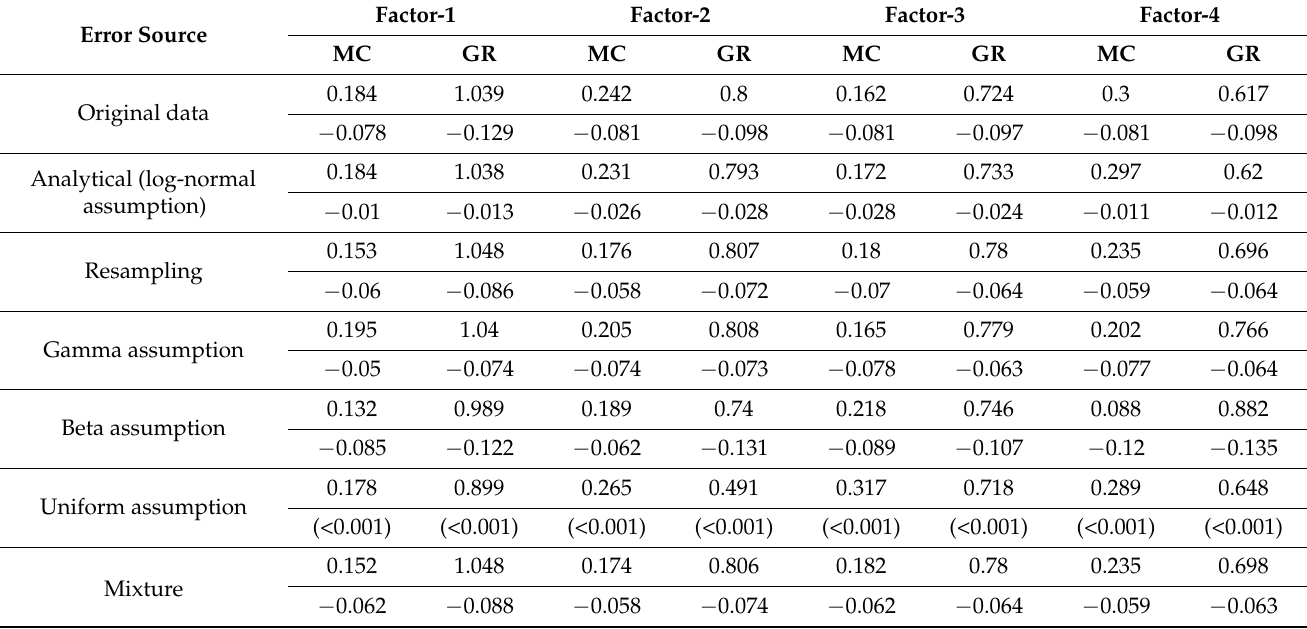
Table 10. Factor score spatial autocorrelation index values for the various datasets (Tables